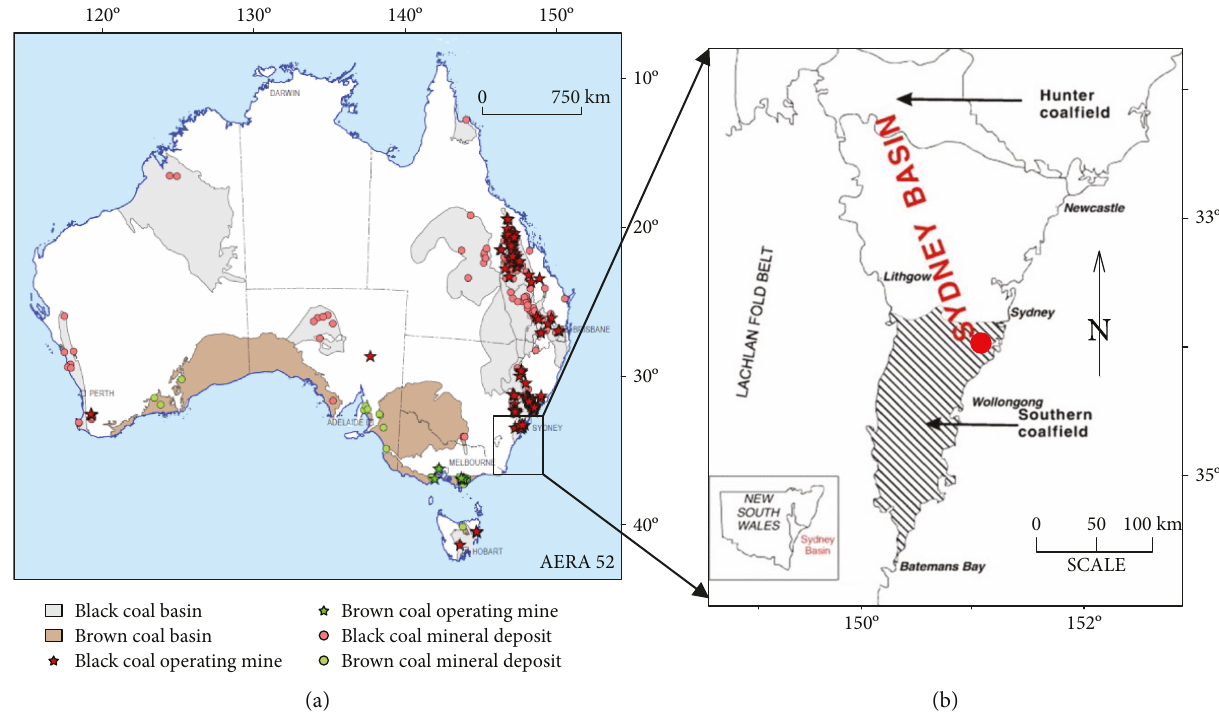
Figure 1: (a) Australia ’ s operating black and brown coal mines [2]; (b) extent of the Southern Coal fi eld of the Sydney Basin; the red dot shows the location of the Metropolitan Colliery (modi fi ed after Ref.